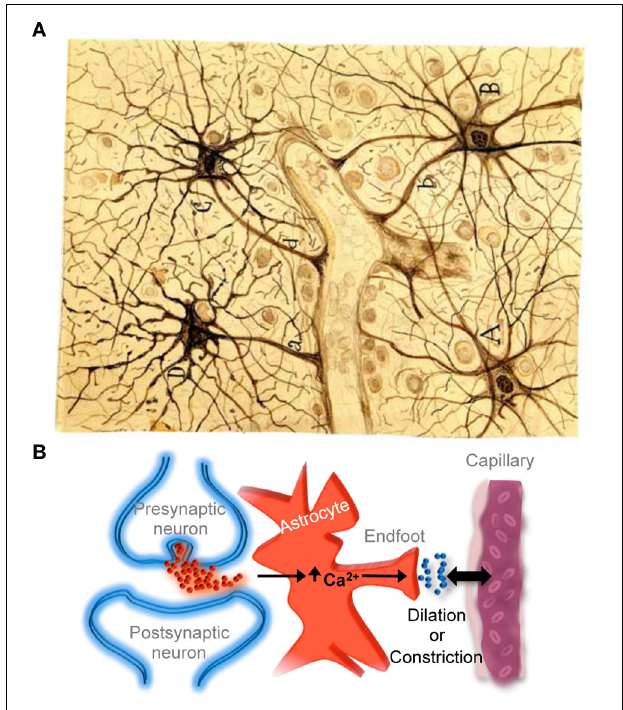
FIGURE 3 | Astrocyte-mediated control of neurovascular coupling. (A) Cajal’s drawing of fibrous astrocytes of human cerebral cortex surrounding a blood vessel. The original slide was impregnated by the sublimated gold chloride method. Reproduced from an original drawing, with permission of the Instituto Cajal. (B) Scheme illustrating that neuronal synaptic activity can signal astrocytes to regulate cerebral microcirculation. It should be noted that much of the neurovascular coupling is achieved through effects on smooth muscle cells that are present in arterioles but not in